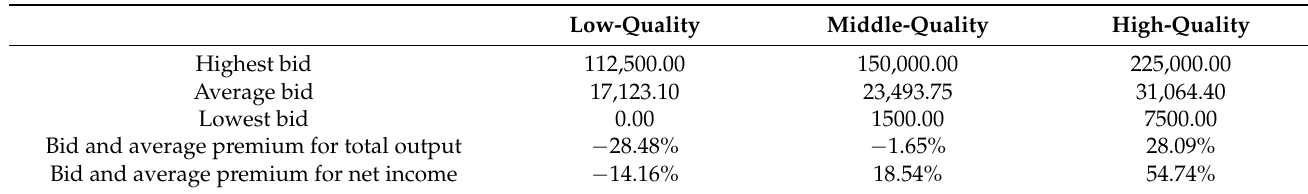
Table 5. Basic situation of auction